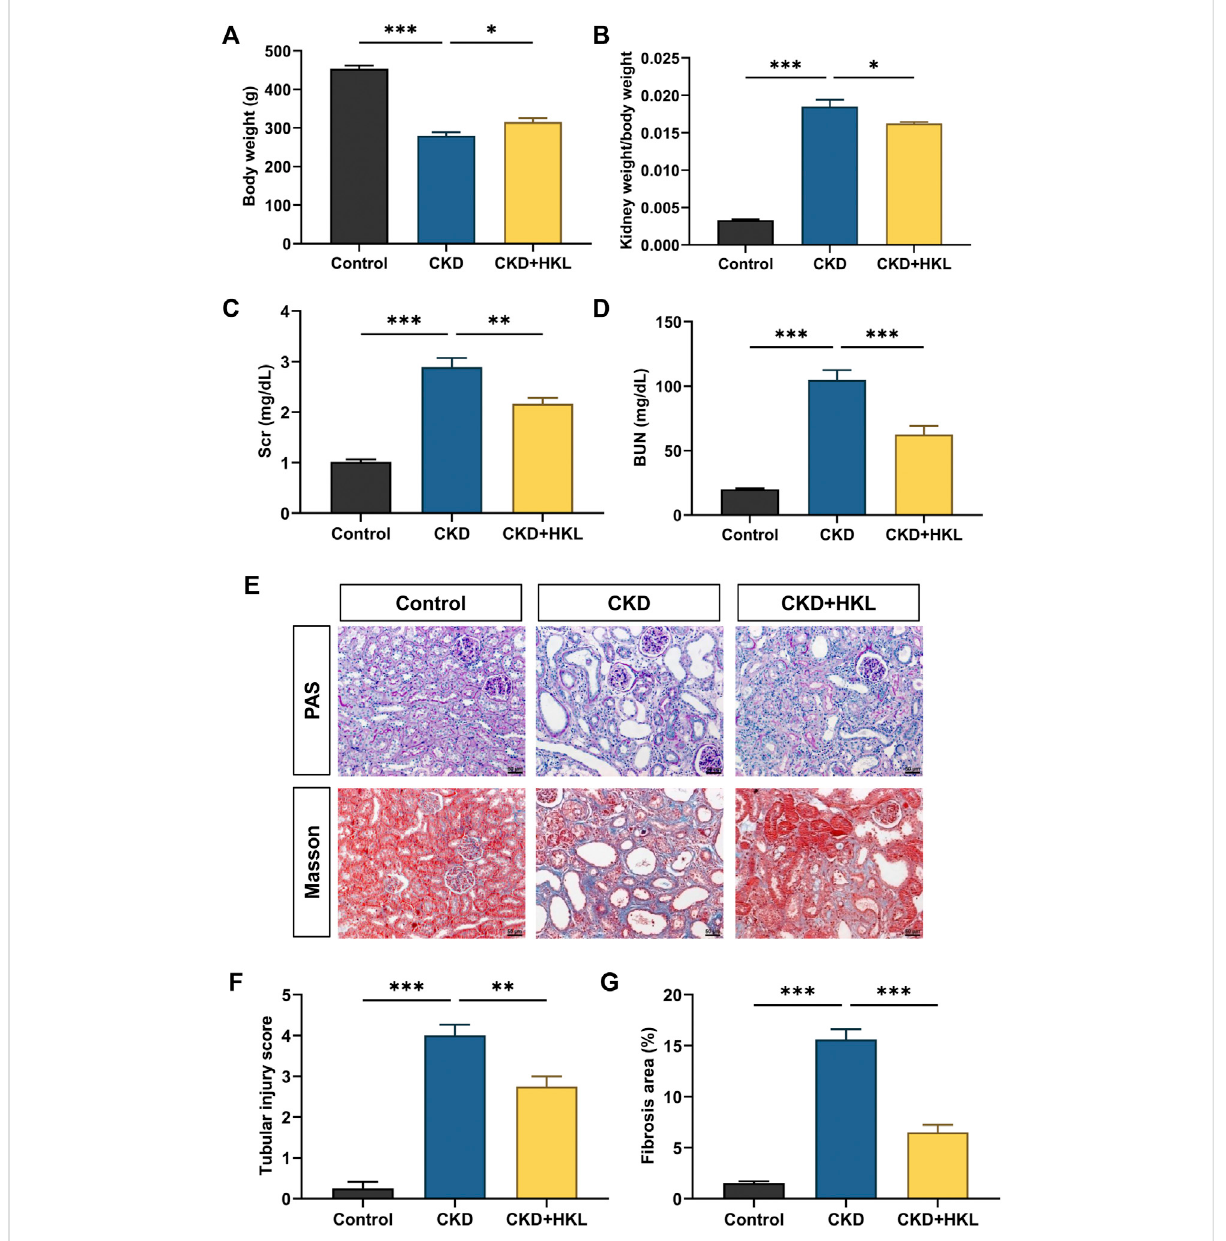
FIGURE 1 Effects of HKL on adenine-induced CKD rats. (A) Body weight. (B) Kidney weight to body weight ratio. (C) Serum creatinine. (D) Blood urea nitrogen. (E) PAS and Masson staining. All images are shown at identical magni fi cation, ×200, scale bar = 50 μ m. (F) Renal tubular injury score. (G) Quanti fi cation of tubulointerstitial fi brosis. Data are expressed as mean ± SEM, n = 4-6 rats per group, * p < 0.05, ** p < 0.01, *** p <